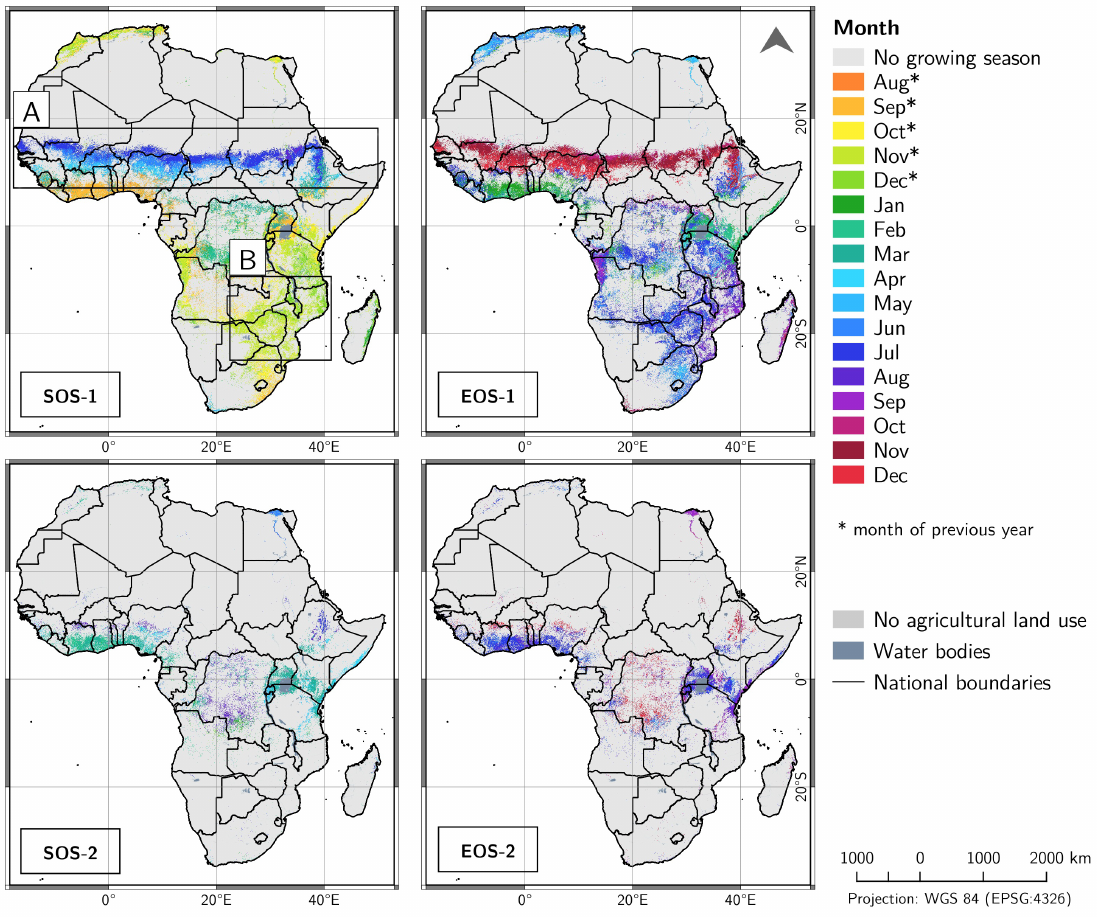
Figure 3. Start and end of detected growing seasons within average seasonal year (SOS-1/SOS-2: start of first/second growing season; EOS-1/EOS-2: end of first/second growing season) for agricultural areas in